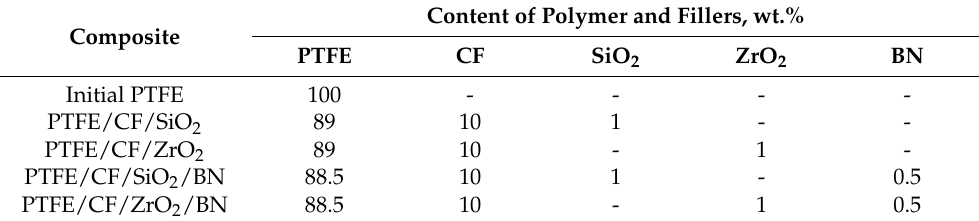
Table 1. Compositions of PTFE composites (wt.%).